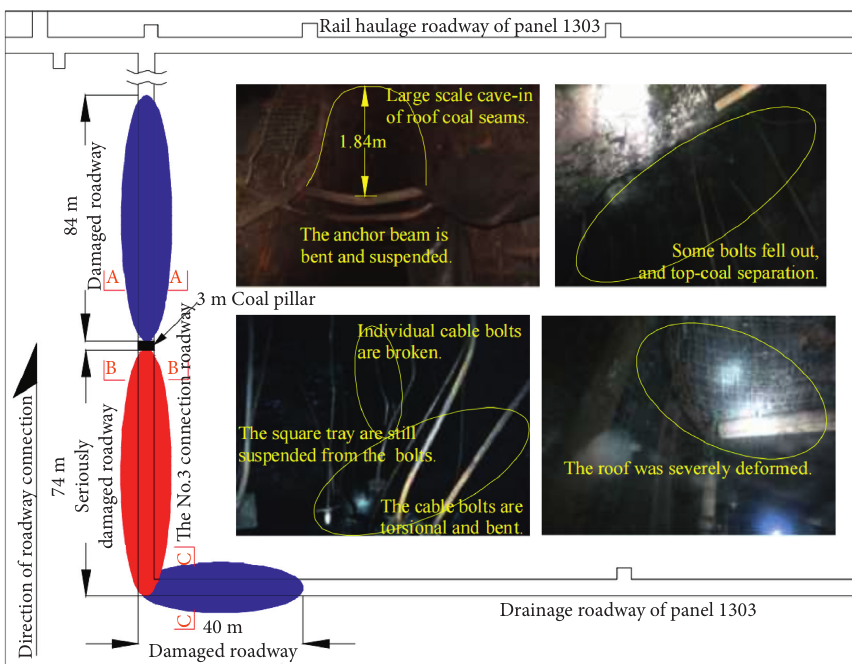
Figure 4: Accident area and roadway